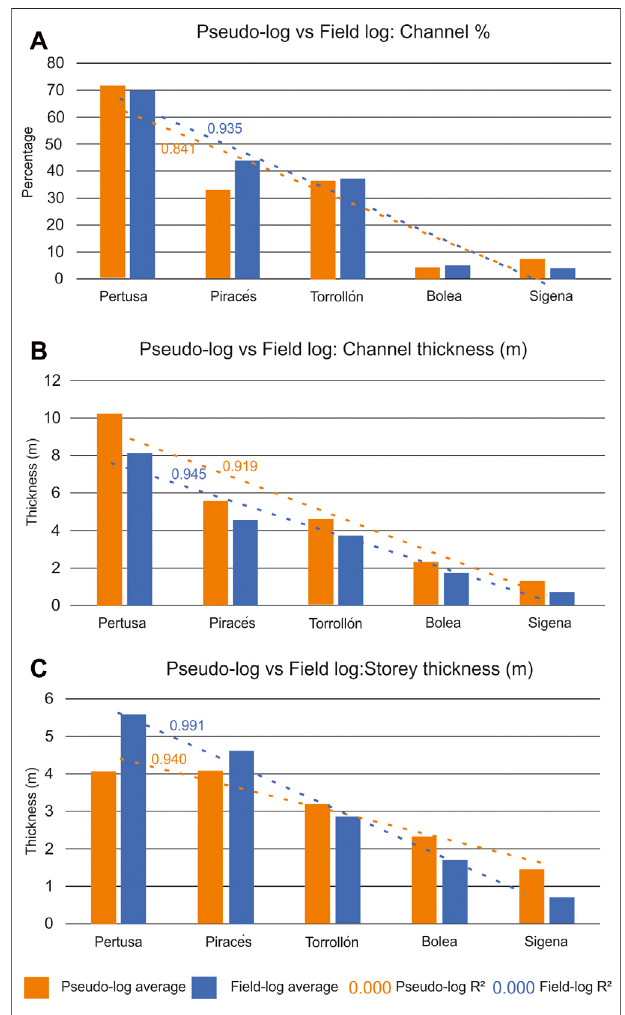
FIGURE 9 | Graphs showing difference between Pseudo log v fi eld datasets. (A) ComparisonbetweenaveragechannelpercentagefromPseudo log data and channel percentage calculated from fi eld logs. (B) Comparison between average channel body thickness from Pseudo log data and average channel body thickness calculated from fi eld logs. (C) Comparison between average storey thickness from Pseudo log data and average storey thickness calculated from fi eld